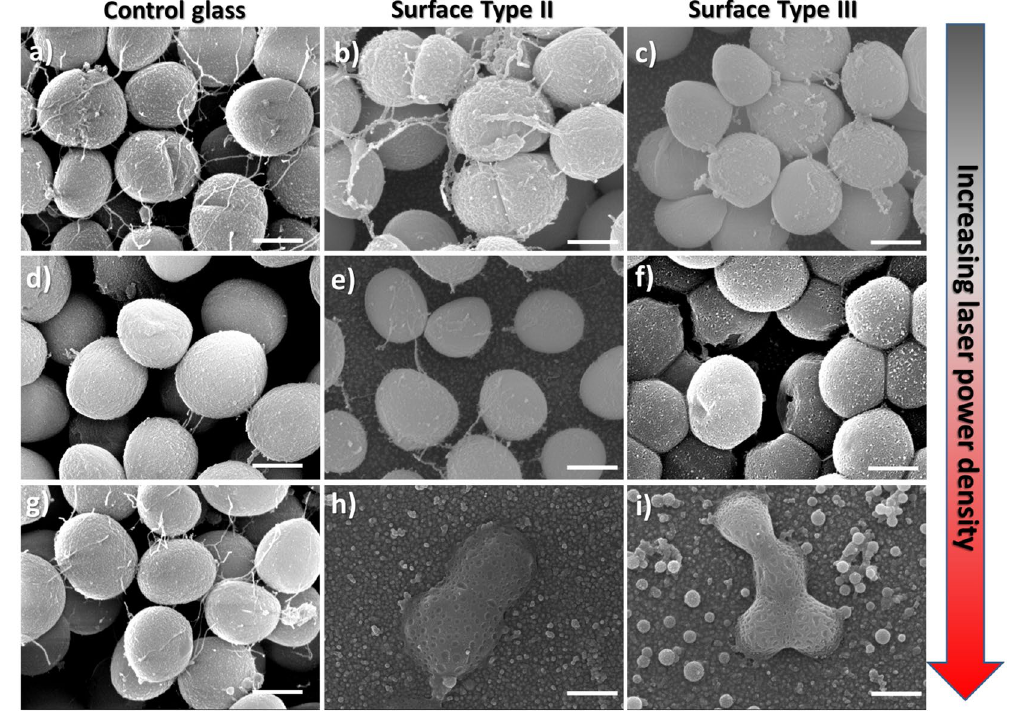
Figure 6. Representative SEM images showing the effect of laser irradiation on S . aureus cells attached to: (by column) ( a , d , g ) Control glass; ( b , e , h ) Type II surfaces (glass|GNS|SiO 2 ); ( c , f , i ) Type III surfaces (glass|GNS|SiO 2 |AgNP). Increasing power density: (by row) ( a , b , c ) Non irradiated samples; Samples irradiated with: ( d , e , f ) 5 × objective lens; ( g , h , i ) 20 × objective lens. All scale bars are 500 nm. Large area SEM images are shown in ESI (SI14 and